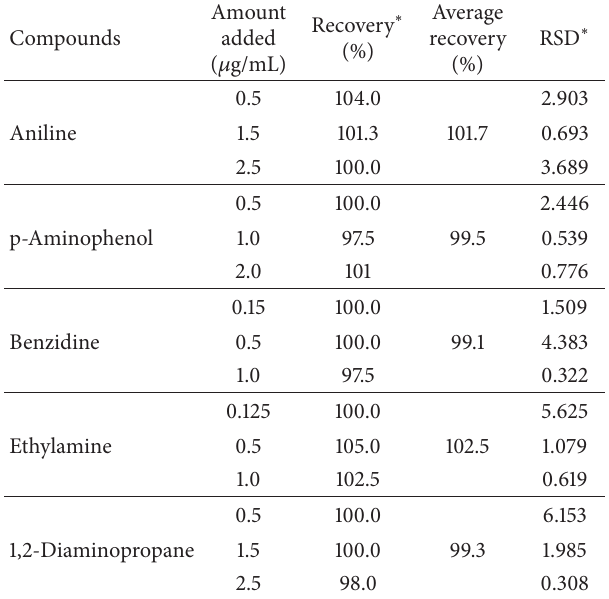
Table 5: Precision and accuracy data for primary amines determi- nation obtained by the proposed method.